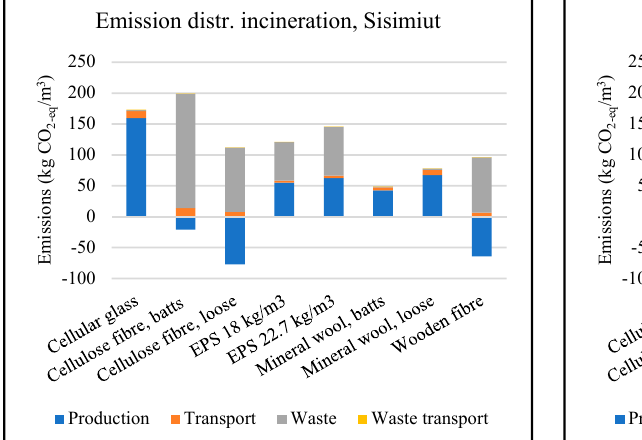
( d ) Figure 3. Graphs presenting some results from ITO. ( a , b ) are for Scen ins , while graphs ( c , d ) are for Scen wall . ( a , d ) consider climate scenarios for dh and oil heating in Nuuk and Sisimiut, while ( b ) and ( d ) presents the development of emissions at different thicknesses for mineral wool in Nuuk and Sisimiut with constant climate. ESL = 60 years.